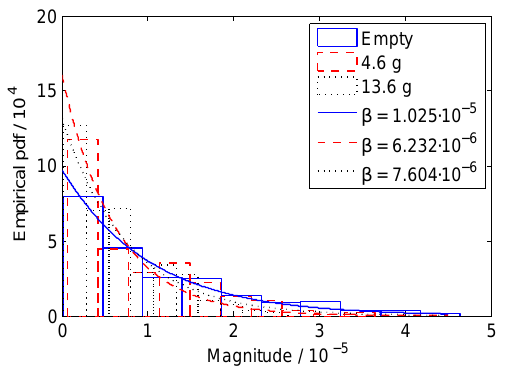
Figure 14. Auto-correlation functions of the UWB magnitude spec- tra in Fig. 12.